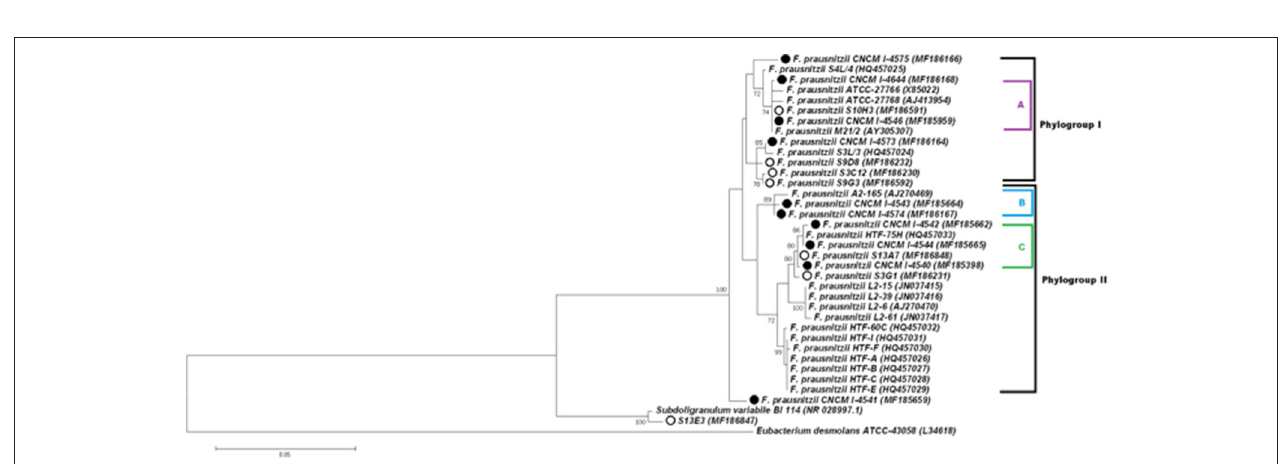
FIGURE 3 | Phylogenetic tree of F. prausnitzii strains based on 16S rRNA gene sequences. The tree was constructed with the MEGA6 software package using the Maximum Likelihood method. The bootstrap values above 70% are shown next to the branches. The F. prausnitzii isolates incorporated in this study have circles besides. The black circles represent the cultured strains and white circles represent uncultured isolates. Colors (purple, blue, and green) and letters (A, B, and C) indicate the tree groups with high bootstrap values, formed by our cultured strains.